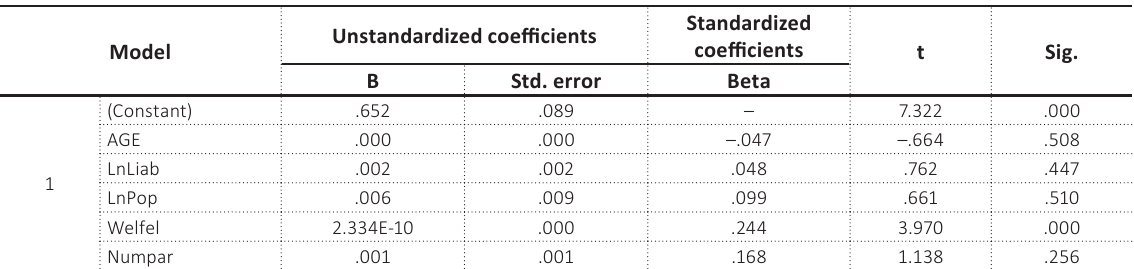
Table 4. Regression